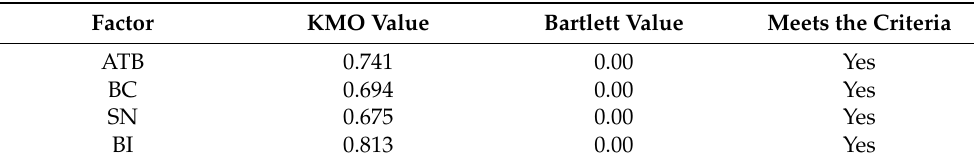
Table 4. Convergent validation of KMO and Bartlett’s sphericity